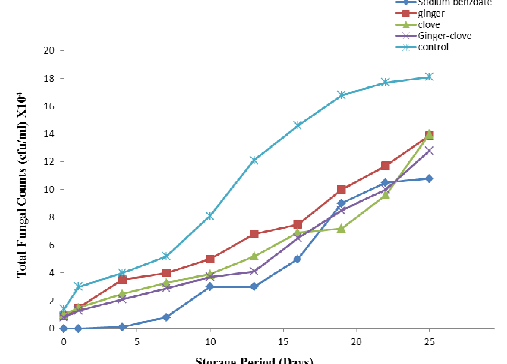
Fig. 5. Effects of different treatments at 3% concentration on the fungal counts of soymilk samples stored at refrigerated temperature for 25 days